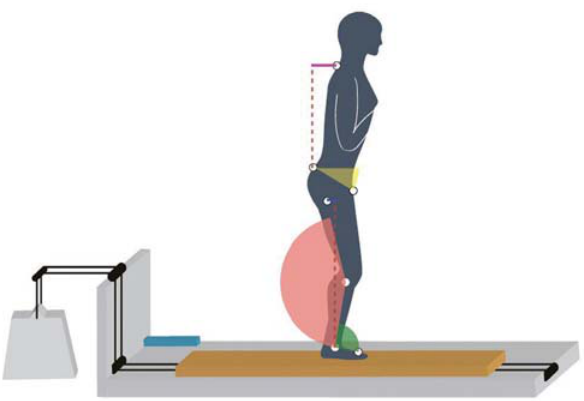
Figure 1 - The movable support surface provided forward and backward standardized perturbations with a mechanical trigger. The variables measured included ankle angle, knee angle, pelvic antepulsion, pelvic anteversion and trunk